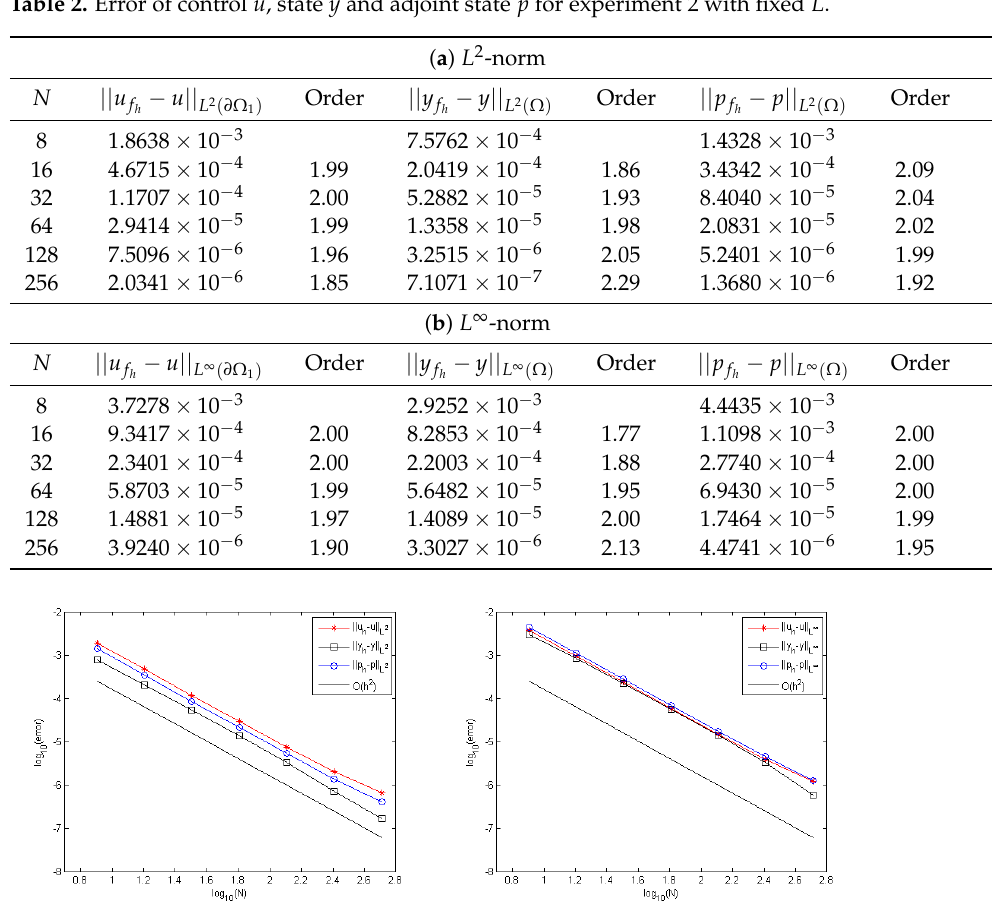
− u , y − y , and p − p in different f h f h h